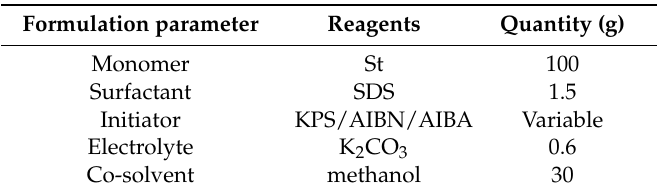
Table 1. The polymerization fundamental recipe for investigating the effect of initiator systems on particle